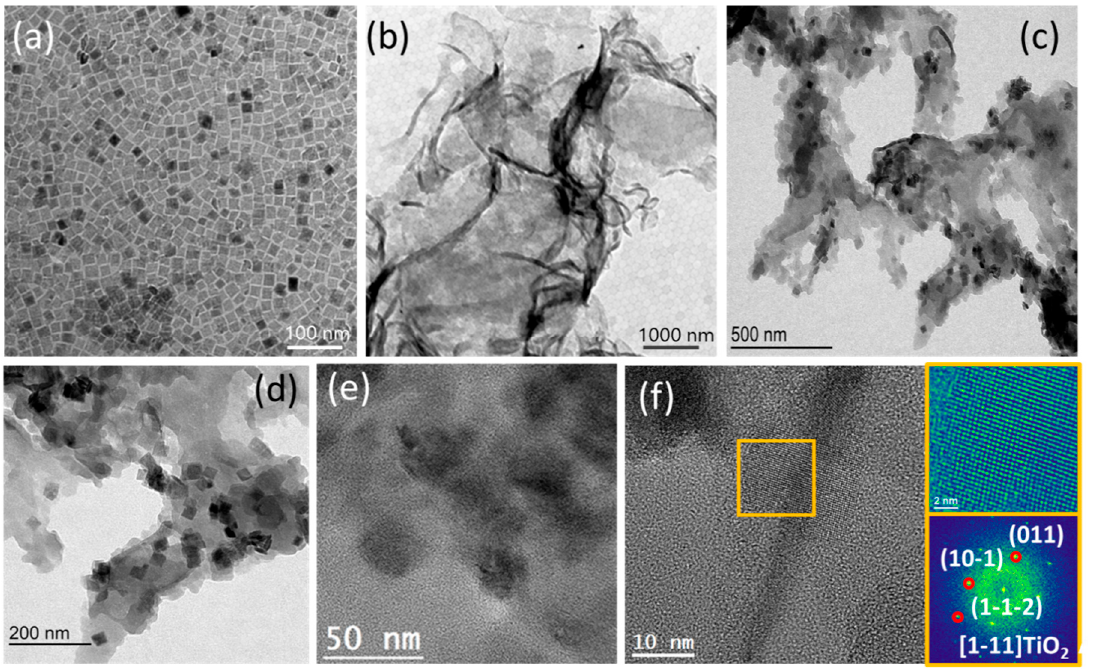
Figure 2. Representative TEM images of ( a ) TiO 2 nanoparticles; ( b ) g-C 3 N 4 nanosheets and T 1 /uCN 1 composite with representative ( c ) low and ( d ) high magnification. ( e , f ) HRTEM images of T 1 /uCN 1 . A magnified detail ( top right ) of the orange squared region in the HRTEM image and its corresponding indexed power spectrum ( bottom right ) is shown, revealing the TiO 2 anatase phase (space group = I4 1 /amd) with a = b = 3.7840 Å, and c = 9.5000 Å. TiO 2 lattice fringe distances were measured to be 0.233 nm, 0.352 nm and 0.348 nm at 41.30° and 139.38°, which could be interpreted as the anatase TiO 2 phase, visualized along its [1–11] zone axis.